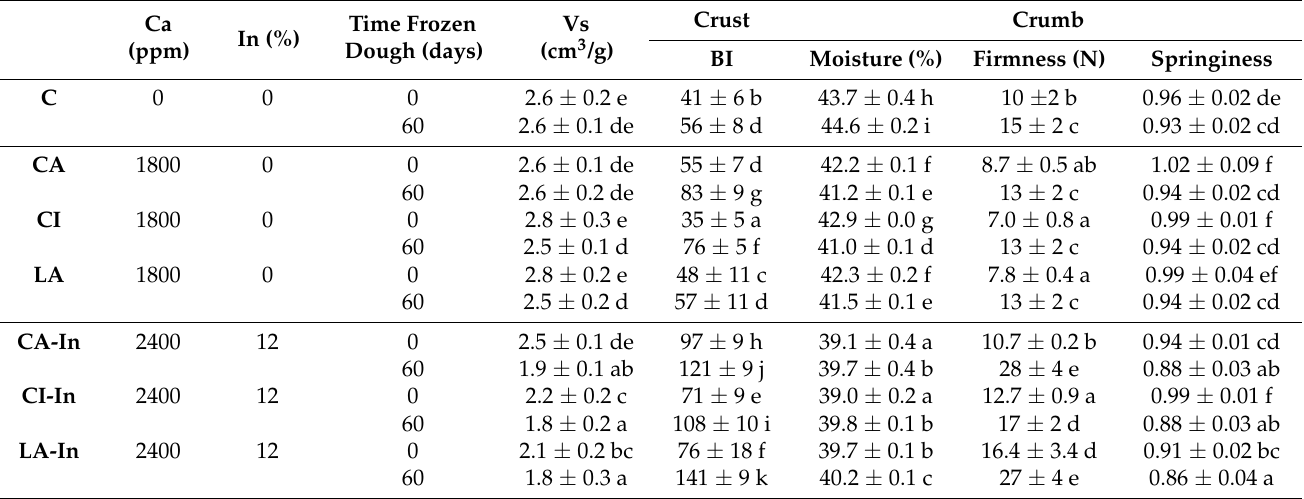
Table 3. Bakery quality of breads prepared with doughs frozen at − 18 ◦ C for 0 and 60